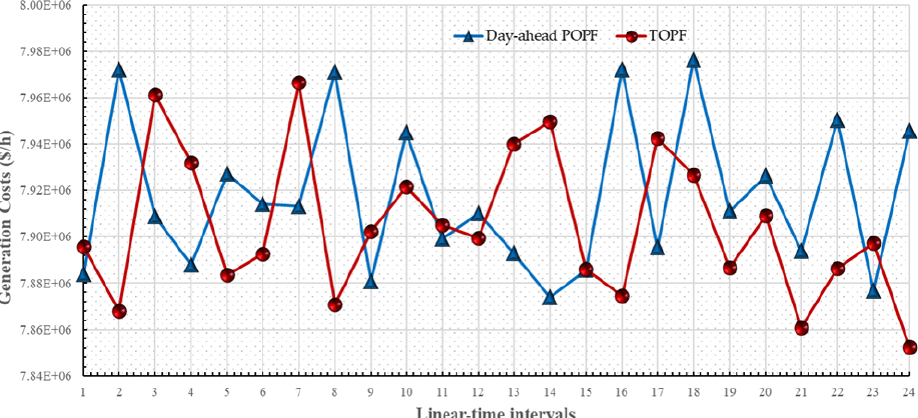
Figure 10. Generation costs of traditional optimal power flow and day-ahead period optimal power